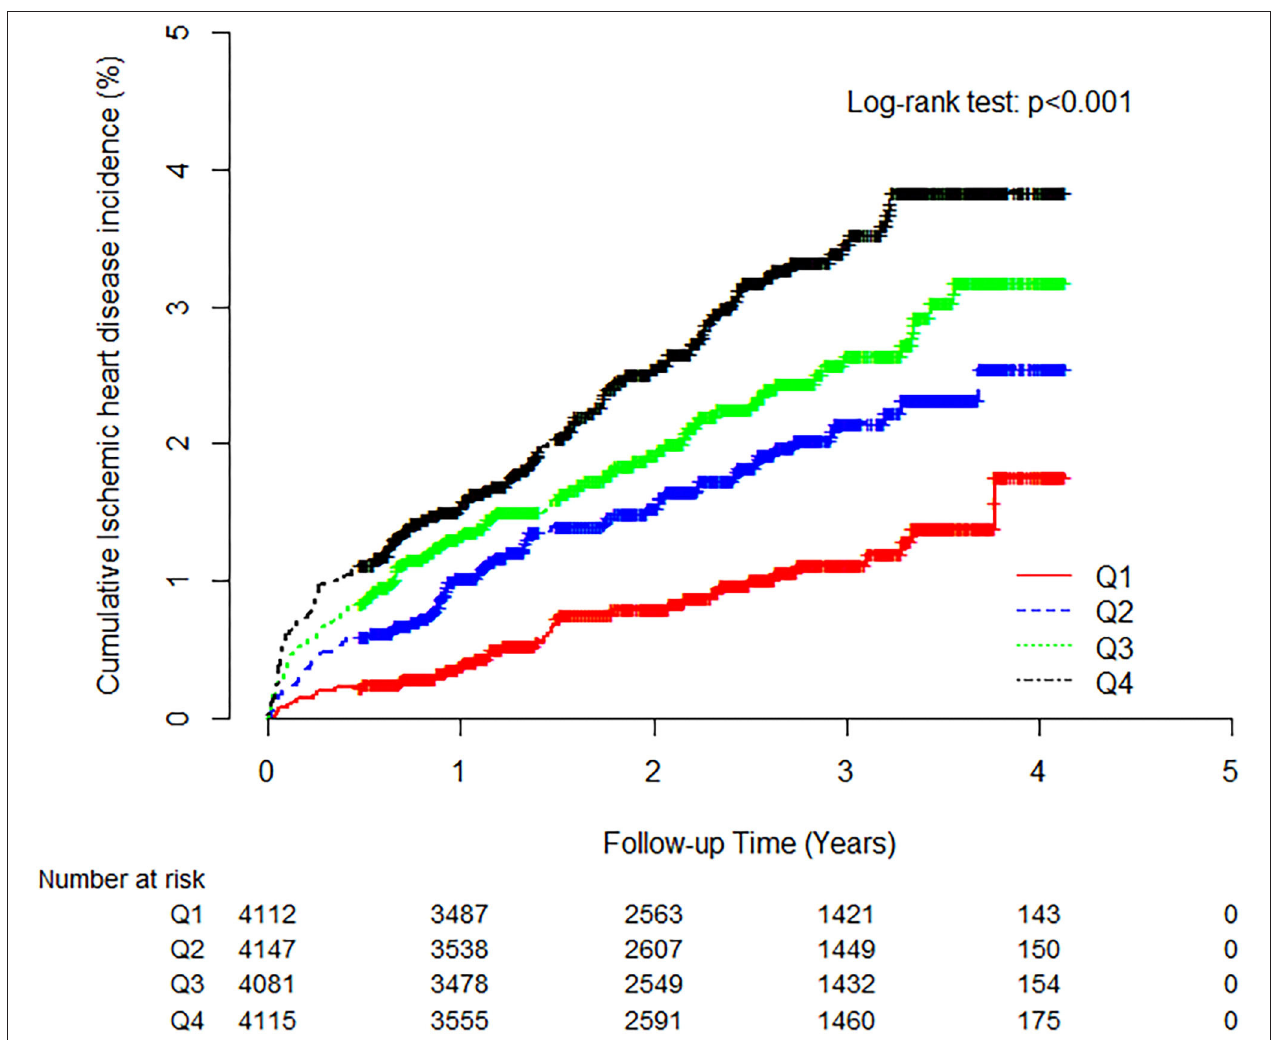
FIGURE 2 | Kaplan-Meier plots indicating the cumulative probability of being diagnosed with ischemic heart disease after the baseline